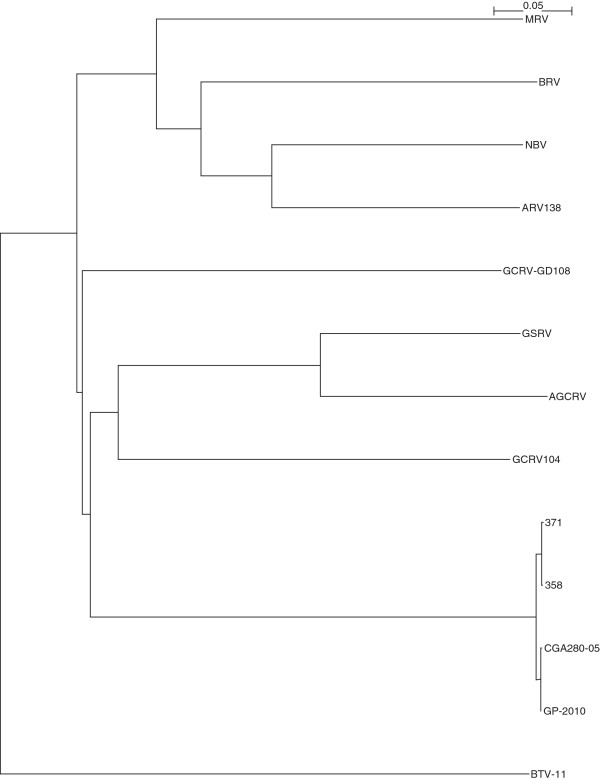
Phylogeny of homologous segment L1 shared by piscine reovirus (PRV) and selected members of familyReoviridae.